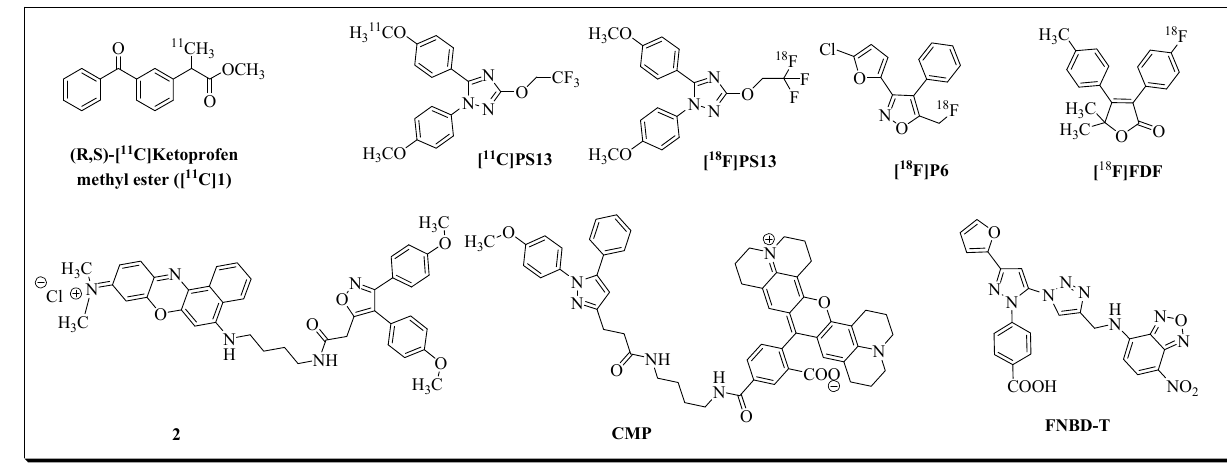
Figure 1. PET and fluorescent imaging probes for COX-1 isozyme.